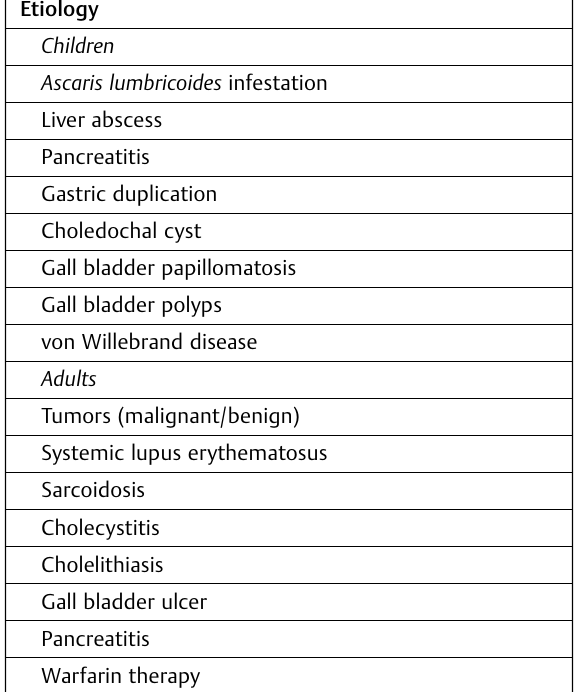
Table 1 Differences of the etiology of hemobilia in children and adults as described in the literature